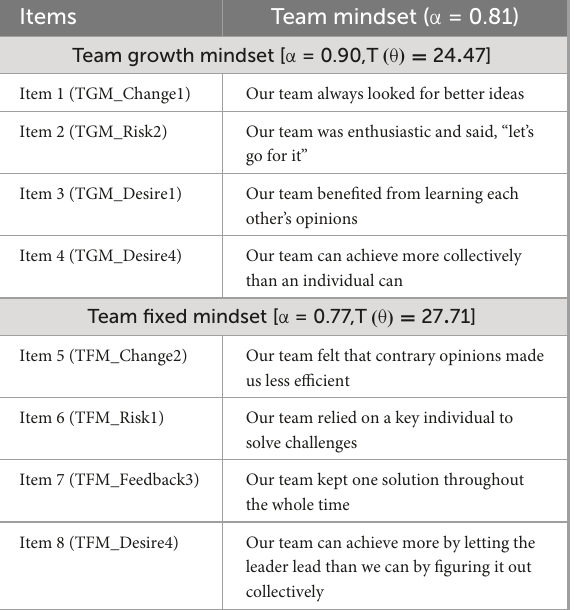
TABLE 4 Team mindset items for short team mindset scale (TMS). Items Team mindset ( α =